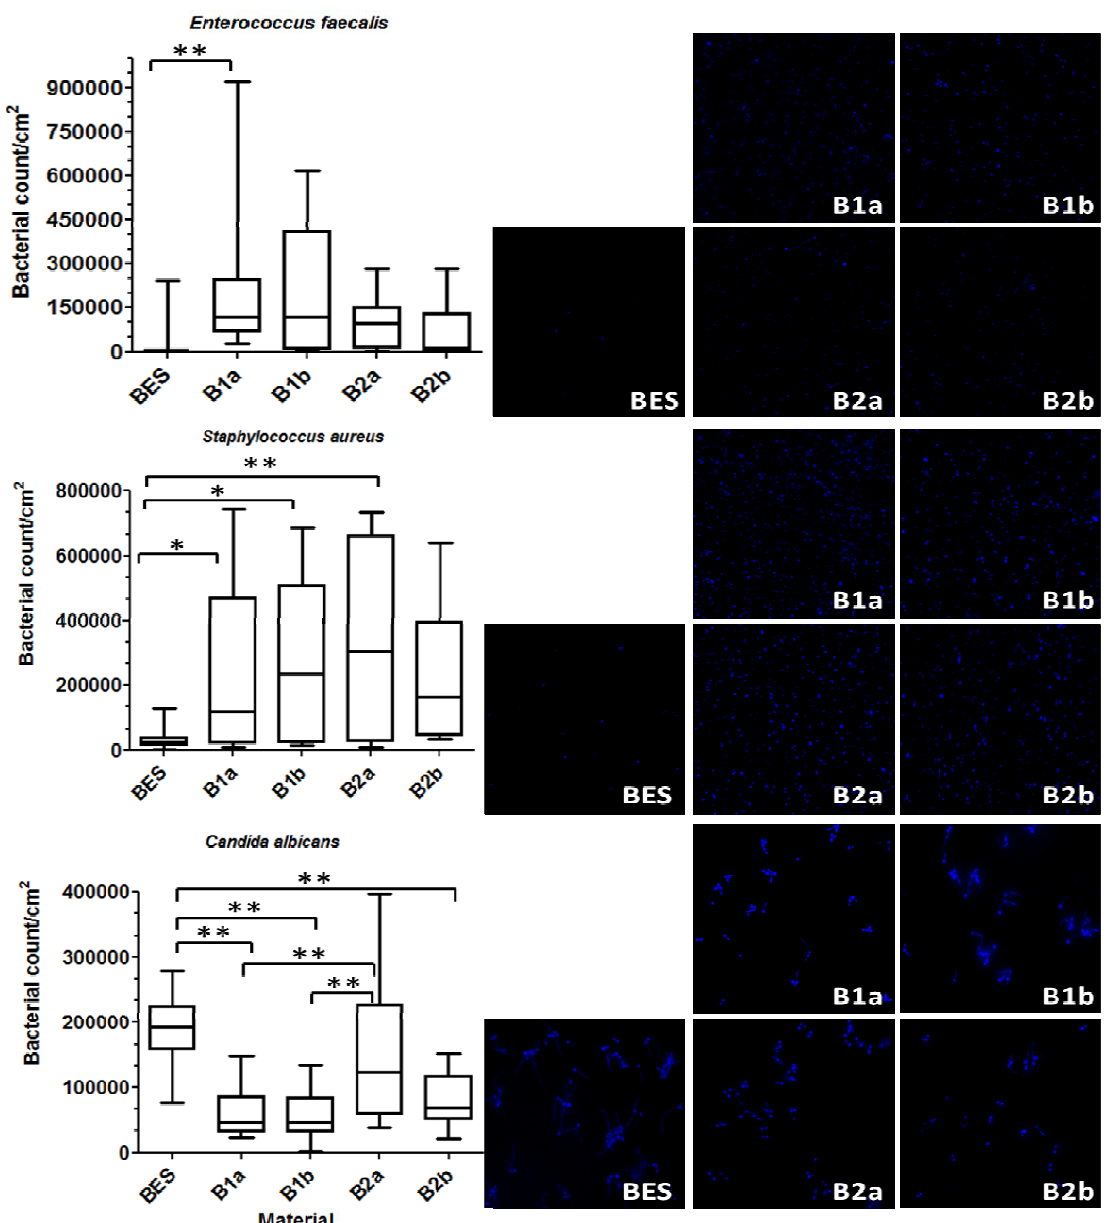
with high surface roughness (Sa ≥ 0.2 µm), while fewer microorganisms were detected on the smoothest surfaces of BES. Figure 2. Boxplots depicting the bacterial count of Enterococcus faecalis , Staphylococcus aureus and Candida albicans on the different implant material surfaces and the control after an exposure time of 2 h. The medians, whiskers, and max/min outliers are displayed. The images on the right show the initial bacterial adhesion of the tested microorganisms on the implant material surfaces after 2 h examined by DAPI staining and followed by fluorescence microscopy. BES: Bovine enamel slabs (control), B1a: 3 mol% yttria-stabilized tetragonal zirconia polycrystal surface; B2a: B1a with zirconium oxide (ZrO ) coating; B1b: B1a with zirconia-based composite coating; B2b: B1a with 2 ) coatings; * p ≤ 0.05, ** p ≤ zirconia-based composite and zirconium oxide (ZrO 2